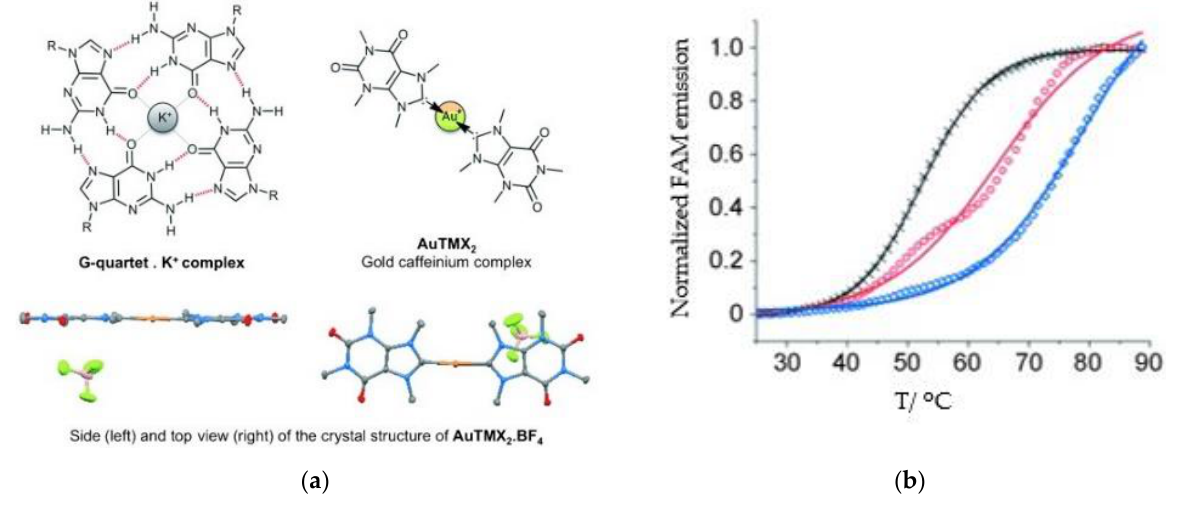
Figure 11. ( a ) Chemical structures of G-quartet (left) and [Au(9-methylcaffeine-8-ylidene) 2 ] + ( AuTMX 2 ) complex; ( b ) graph of FRET melting results of AuTMX 2 ; 0.2 μ M DNA with AuTMX 2 (red curve) and withthout any ligands (black curve). Adapted with permission from Ref. [108]. Copyright (2012) Wiley-VCHVerlag GmbH & Co. KGaA, Weinheim.